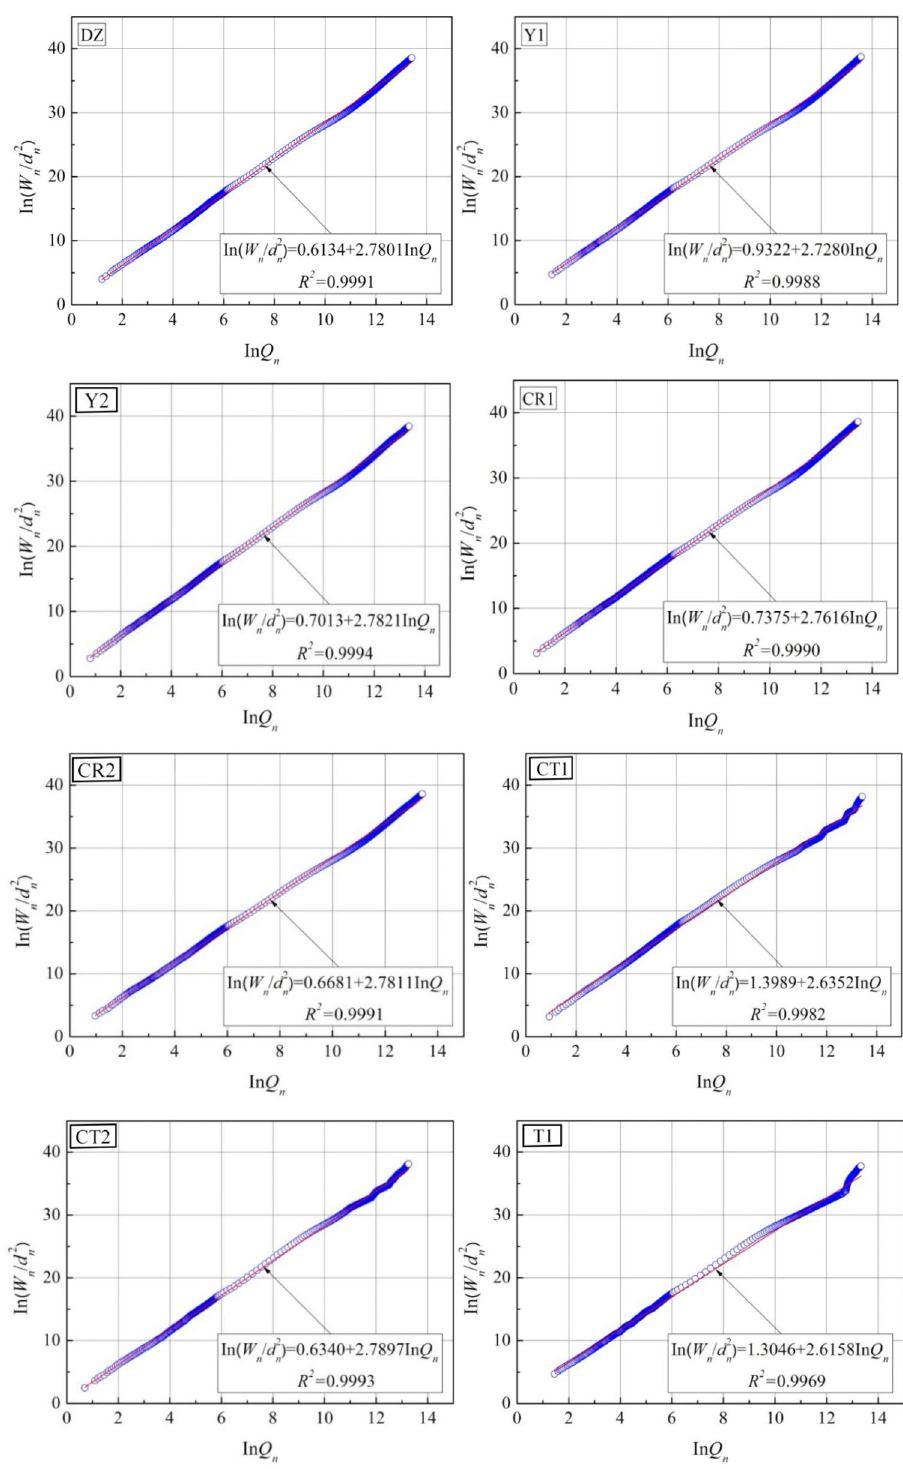
Figure 13. ln ( W n / d 2 n ) − ln Q n scatter plots and fitted